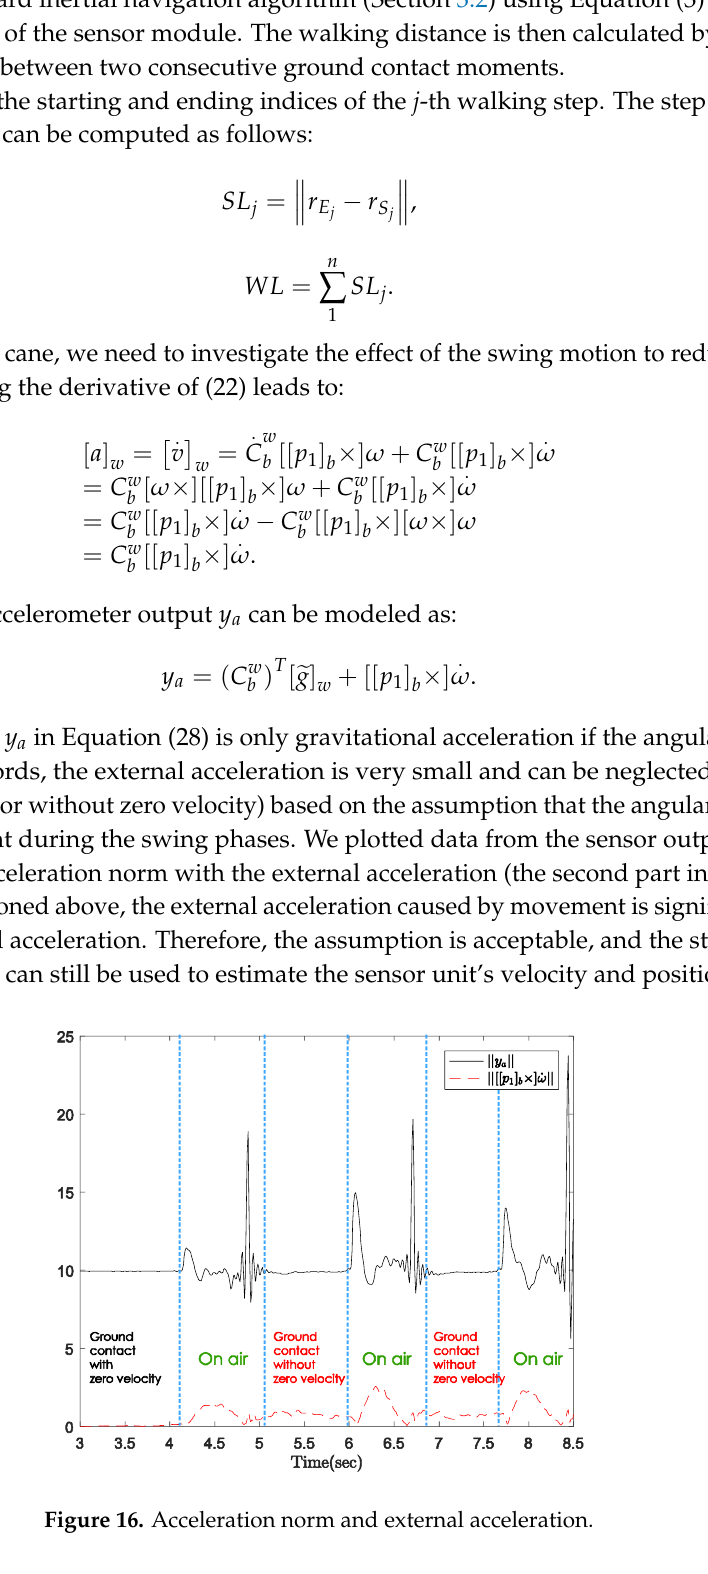
Figure 15. Velocity updating procedures for a standard cane.